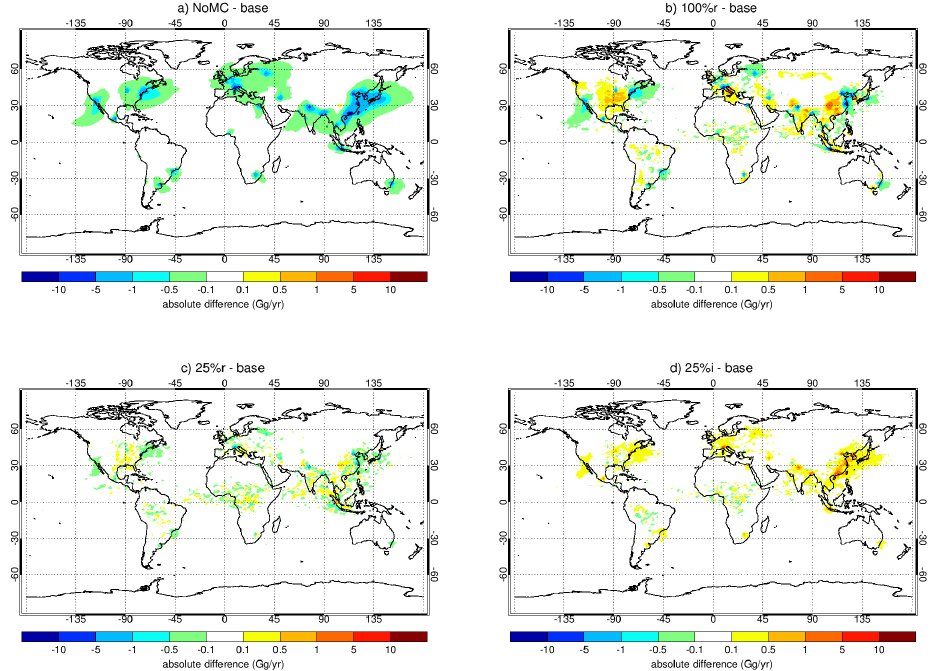
Fig. 9. Annual average changes in NO y deposition Ggyr − 1 for each of the scenarios (perturbation - base). Perturbation scenarios are (a) annihilation run (label:NoMC)-base, (b) 100% redistribution run (label:100%r)-base, (c) 25% redistribution run (label:25%r)-base and (d) 25% increase run (label:25%i)-base.